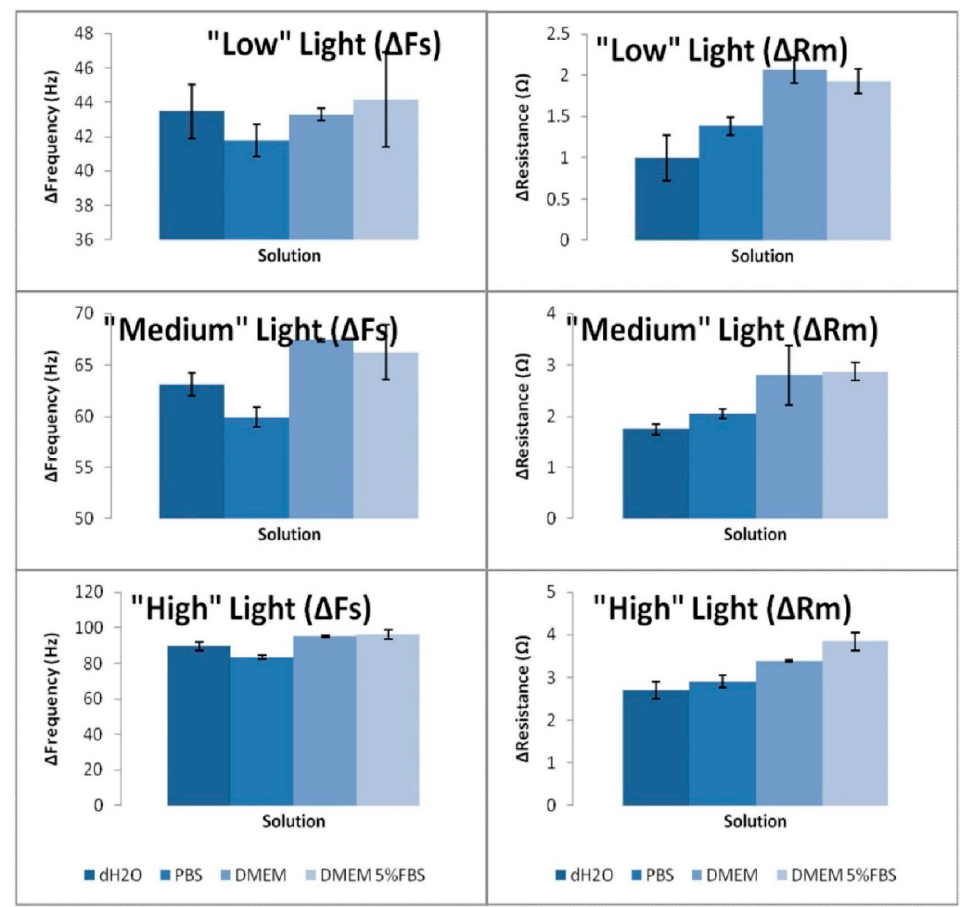
Figure 2. Changes in Fs and Rm for exposure of bare TSM electrodes to various solutions and light intensity conditions .